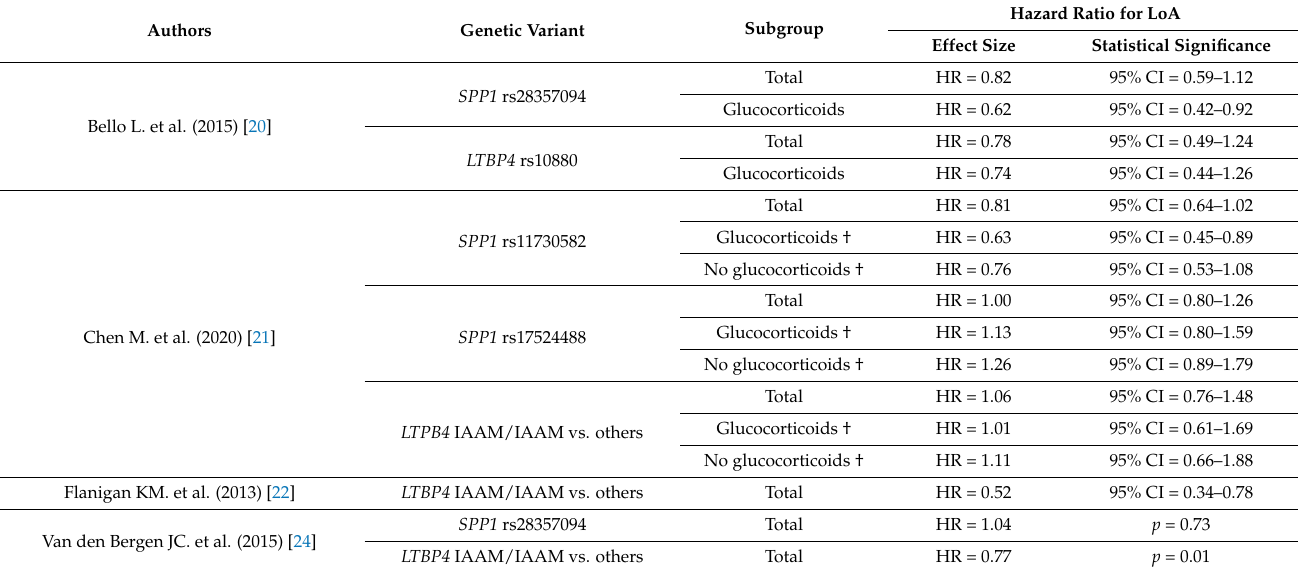
Table 3. Studies including as outcome age of loss of ambulation (Cox regression analyses).